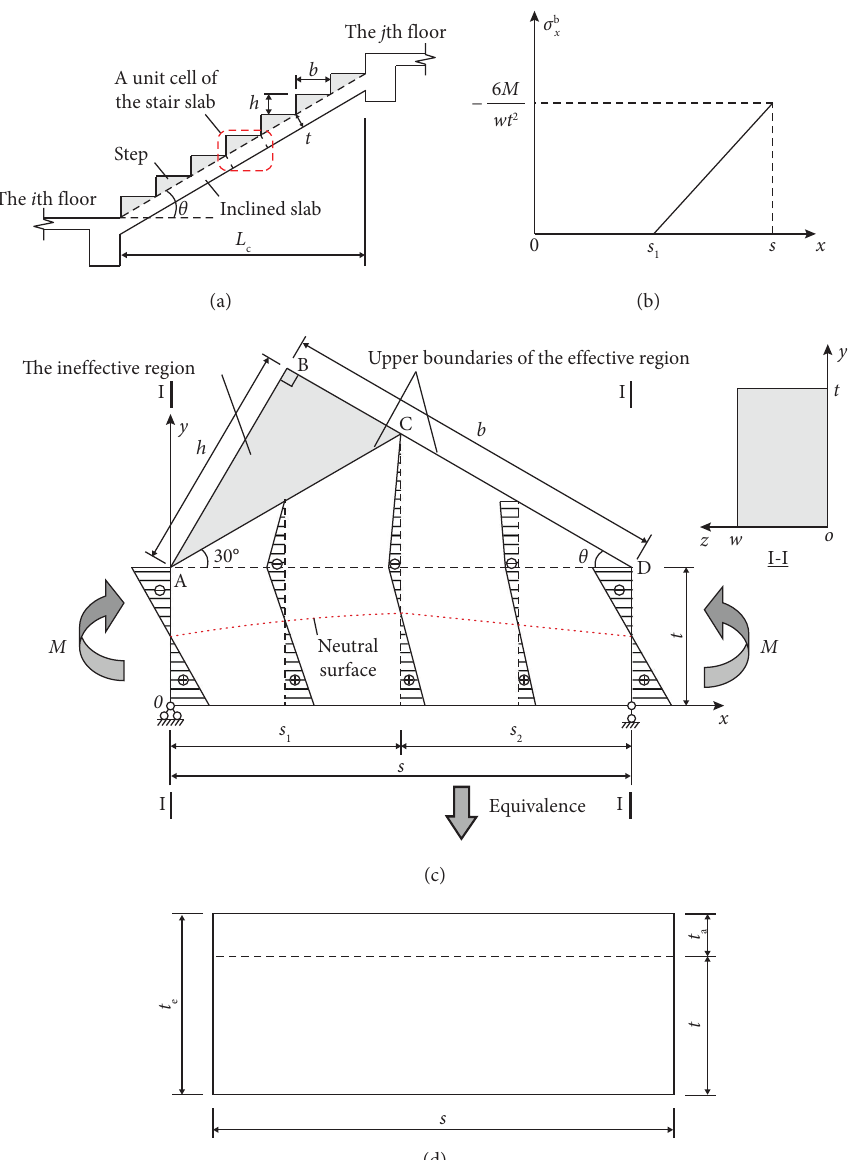
Figure 1: Schematicdiagrams of a stair slab and the analysis model of a unit cell. (a) A stair slab consisting of an inclined slab and a series of identical steps. (b) Te assumed normal stresses in the path A-C-D for the unit cell. (c) Te normal stress distribution of the unit cell. (d) Te equivalent fat